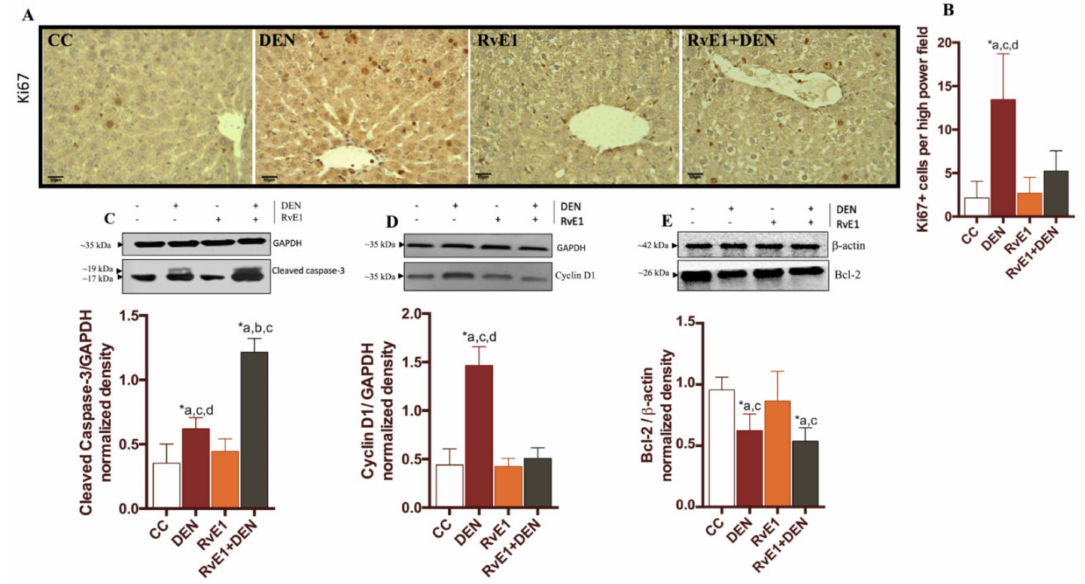
Figure 4. Effect of RvE1 on cell cycle and apoptosis. ( A ) Representative histopathological microphotography tissue Ki67 at 400 × magnification. ( B ) Quantification of Ki67 positive cell. Western blot analysis of ( C ) Cleaved caspase-3, ( D ) Cyclin D1 and ( E ) BCL-2. The levels were normalized to GAPDH or β -actin as housekeeping. n = 6–9 rats per experimental group. Asterisk indicates p < 0.05, and the letters identify the experiments that are compared and present this statistical